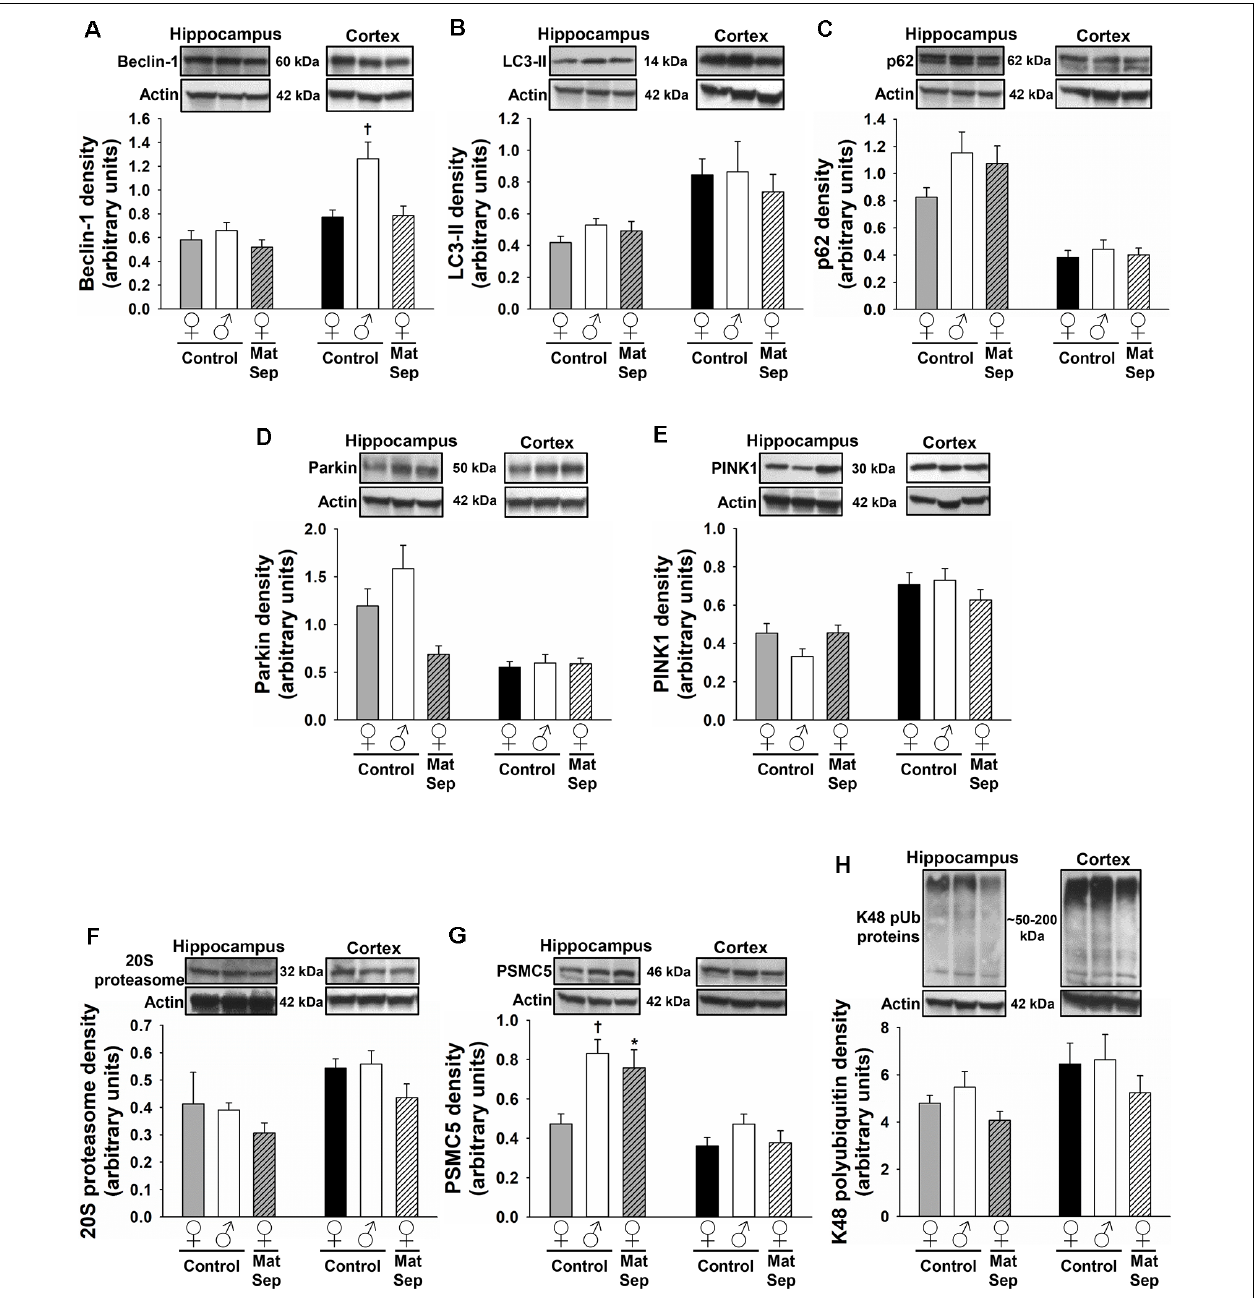
FIGURE 5 | Immunoblot analysis of proteostasis markers from hippocampal (gray-white bars) and cortical (black-white bars) homogenates from aged rats. Panels above each graph show representative blots depicting the ALP markers beclin-1 (A) , LC3-II (B) , and p62 (C) ; the mitophagic proteins parkin (D) and PINK1 (E) ; and the UPS markers 20S proteasome (F) , PSMC5 (G) , and K48 pUb proteins (H) . Actin was used to normalize protein band density over at least three separate blots in all cases. * p ≤ 0.05 vs. same-sex Controls; † p ≤ 0.05 when comparing between sexes.